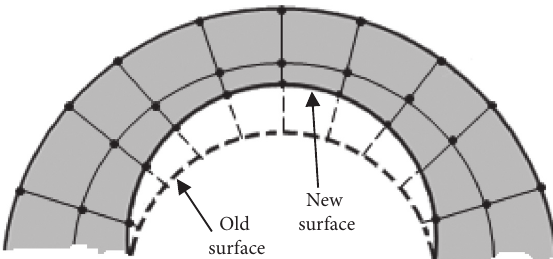
Figure 4: Elastic foundation model.